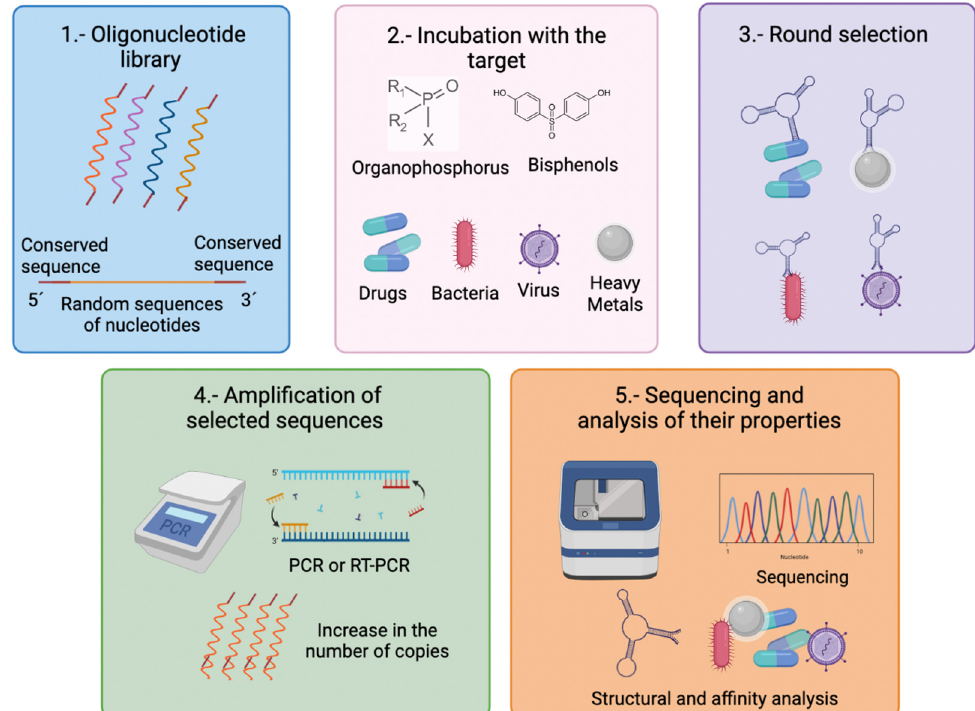
Figure 1. Schematic illustration of the methodology followed for the development of in vitro aptamers by the SELEX method (Systematic evolution of ligands by exponential enrichment). ( 1 ) Aptamers are formed by DNA or RNA from a library that can be commercial; these sequence at their 5 ′ and 3 ′ ends present conserved regions, while their internal nucleotide sequence is random. ( 2 ) Aptamers are incubated with the target of interest (drugs, viruses, bacteria, endocrine-disrupting chemicals, or heavy metals). ( 3 ) In total, 8–15 cycles of selection rounds are performed to separate the sequences that present affinity for the target and discard those unbound to the target. ( 4 ) The selected sequences are amplified through the conserved regions at their 5 ′ and 3 ′ ends by hybridizing the primers in these regions. ( 5 ) Finally, the properties of the selected aptamers are sequenced and analyzed. Created with BioRender.com.